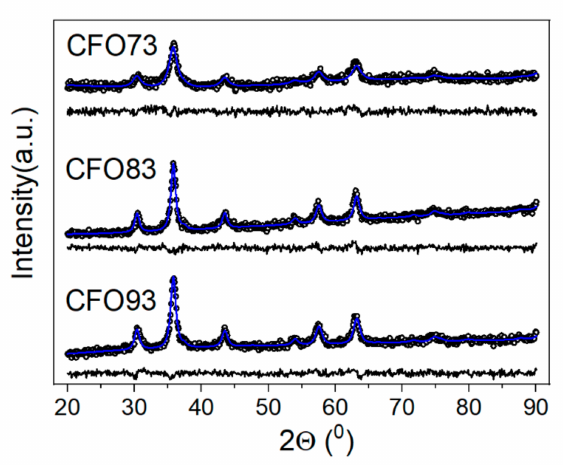
Figure 1. Rietveld refinements of XRD data for CFO73 (pH = 7.3), CFO83 (pH = 8.3), and CFO93 (pH = 9.3).